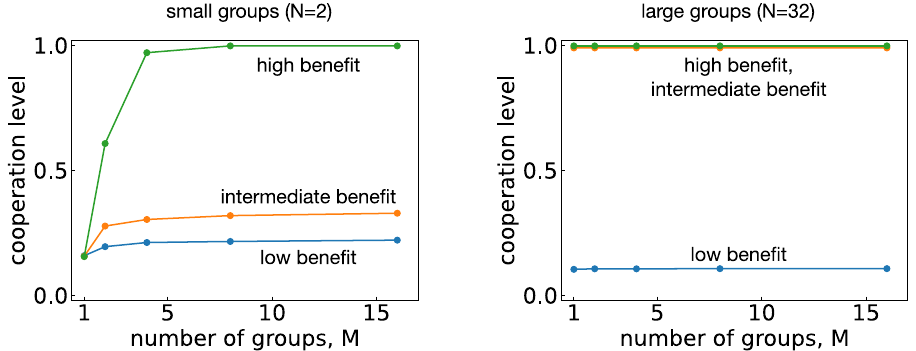
Figure 2. Cooperation levels as functions of the number of groups M for small groups ( N = 2 ) and large groups ( N = 32 ). The curves corresponds to high benefit ( b = 6 ), intermediate benefit ( b = 3 ), and low benefit ( b = 1.5 ) from top to bottom. When groups are small, we see more cooperation when we increase the number of groups. In contrast, when each group is large, the exact number of groups has little effect on the average cooperation